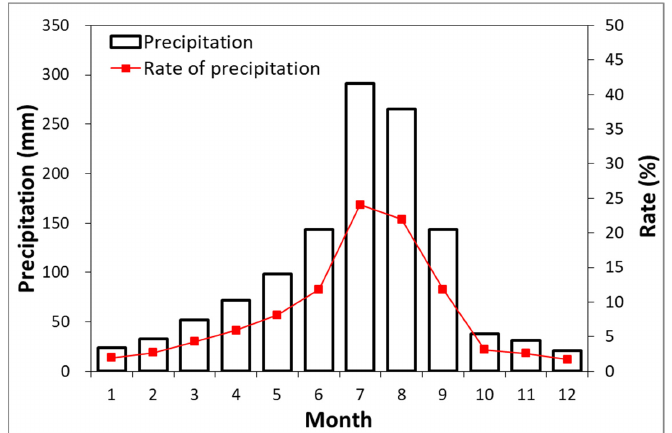
Figure 3. Monthly precipitation and rate of precipitation in Sangju Rainfall Station (1981–2013) (Gyeongsangbuk-Do, 2011).